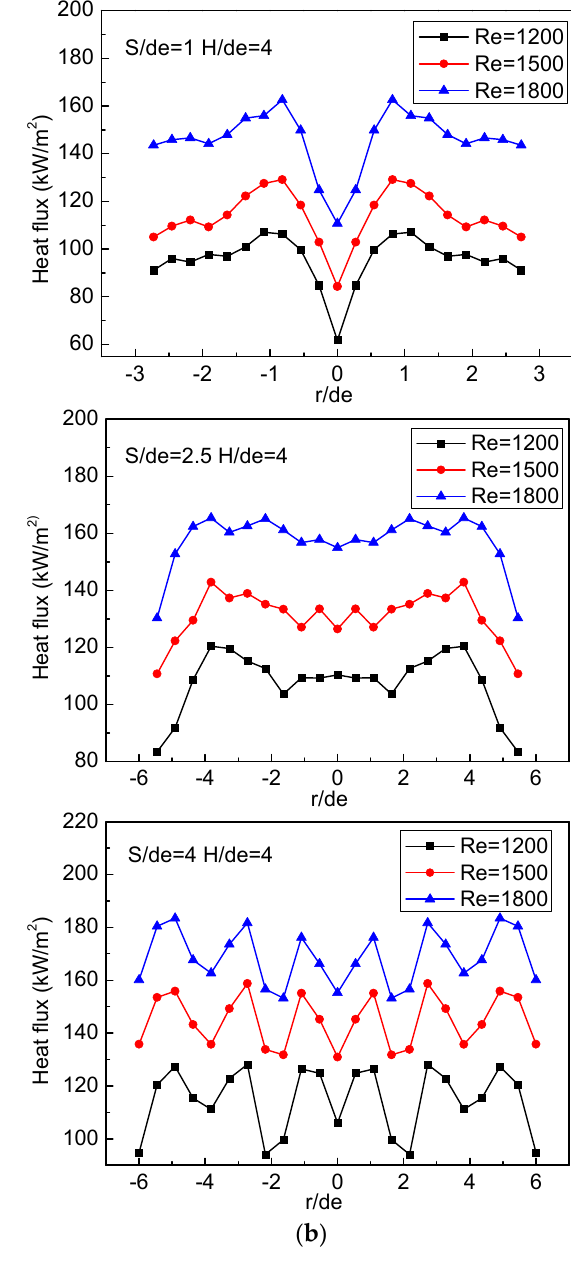
Figure 2. ( a ) Heat flux distribution along the slot width direction of an LPG premixed flame array at H/de = 2; ( b ) Heat flux distribution along the slot width direction of an LPG premixed flame array at H/de = 4.